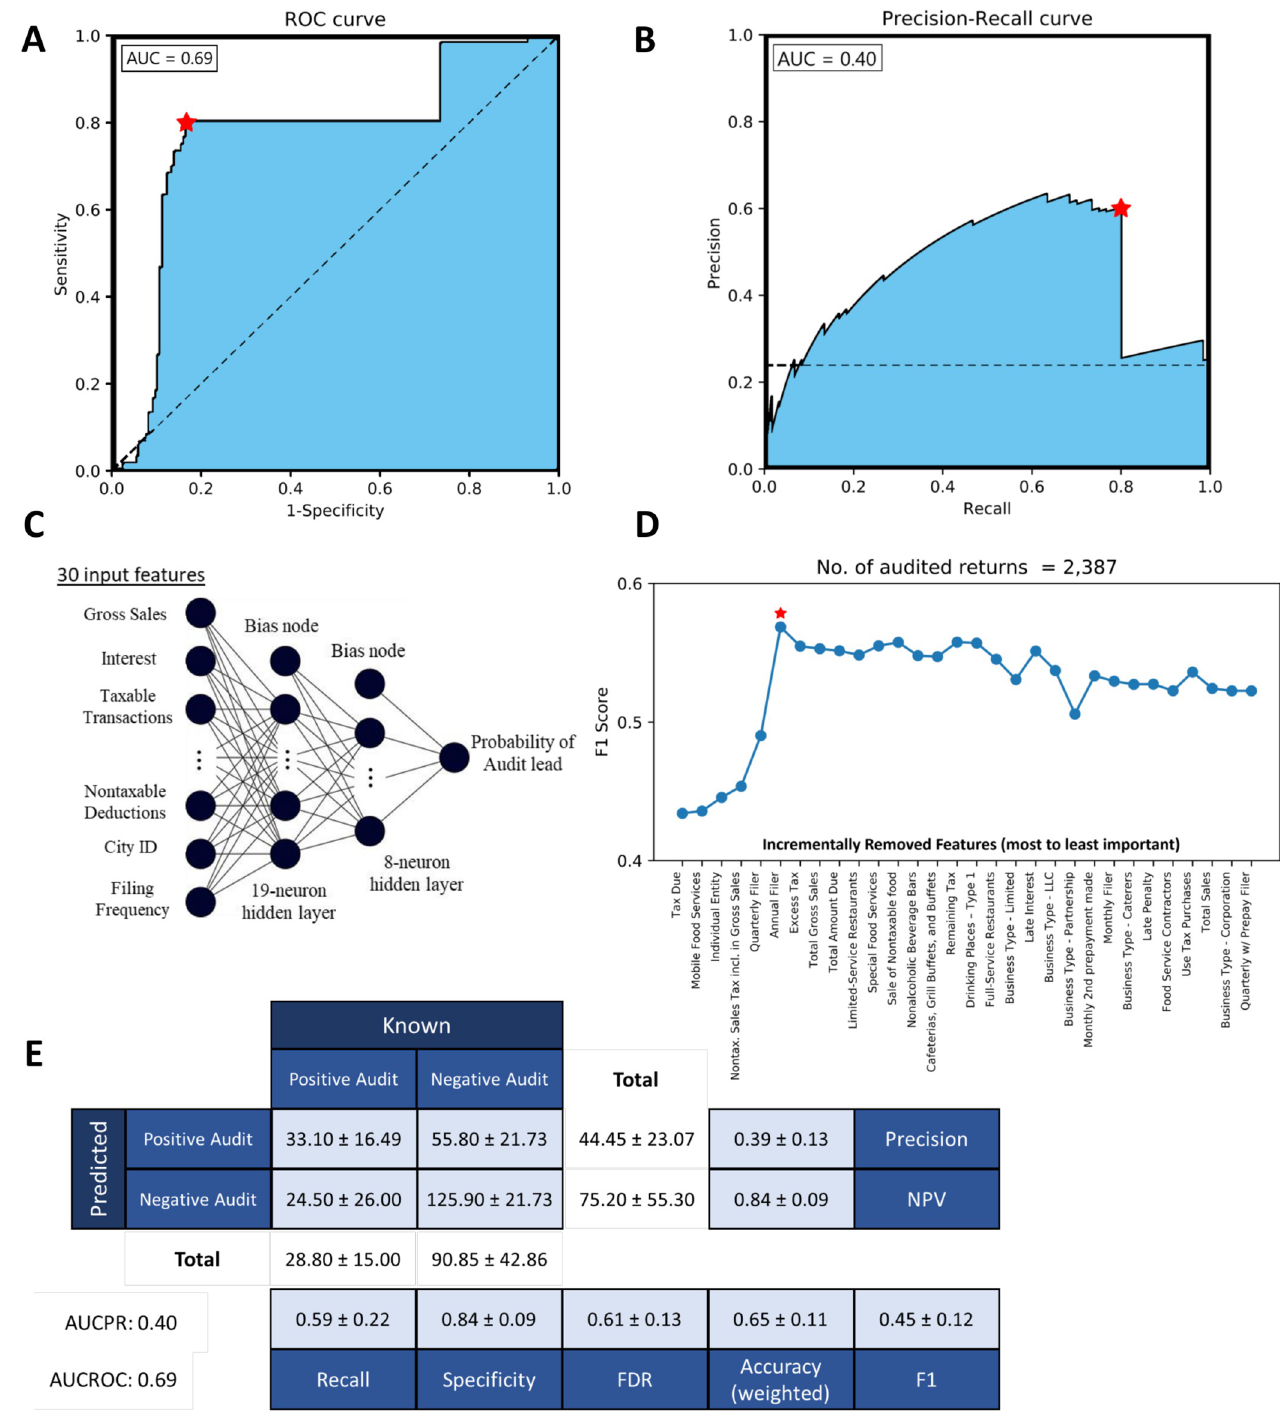
Fig 4. (A) Receiver operating characteristic (ROC) curve, (B) precision-recall curve, and (C) audit lead classifier architecture with (D) recursive feature elimination results. The red star signifies the feature added after which model performance no longer improves. (E) displays the confusion matrix for the trained classification model. The average F 1 score for the positive class was 0.45 across all 10 folds, with AUROC and AUPRC being 0.86 and 0.47, respectively.